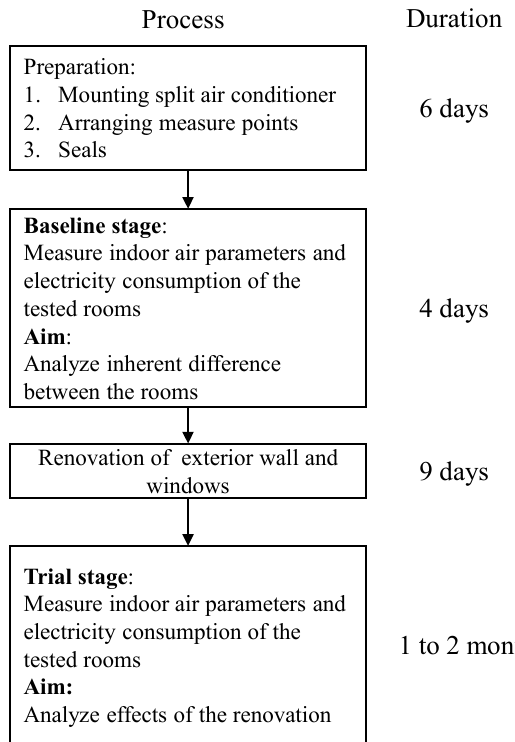
Figure 5. Flow diagram of the field test.